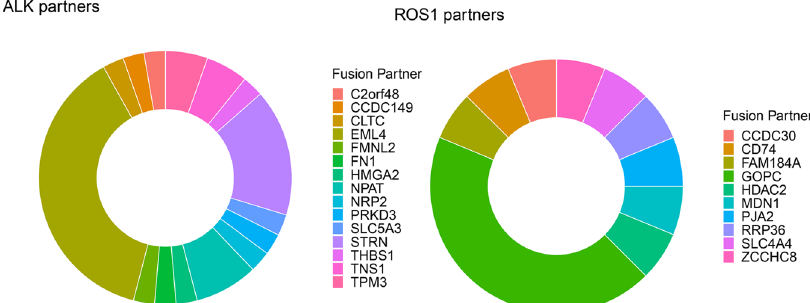
Fig. 3 Fusion partners for ALK and ROS1 in the expanded molecular cohort. The most common fusion partners are shown for ALK and ROS1 from the expanded molecular